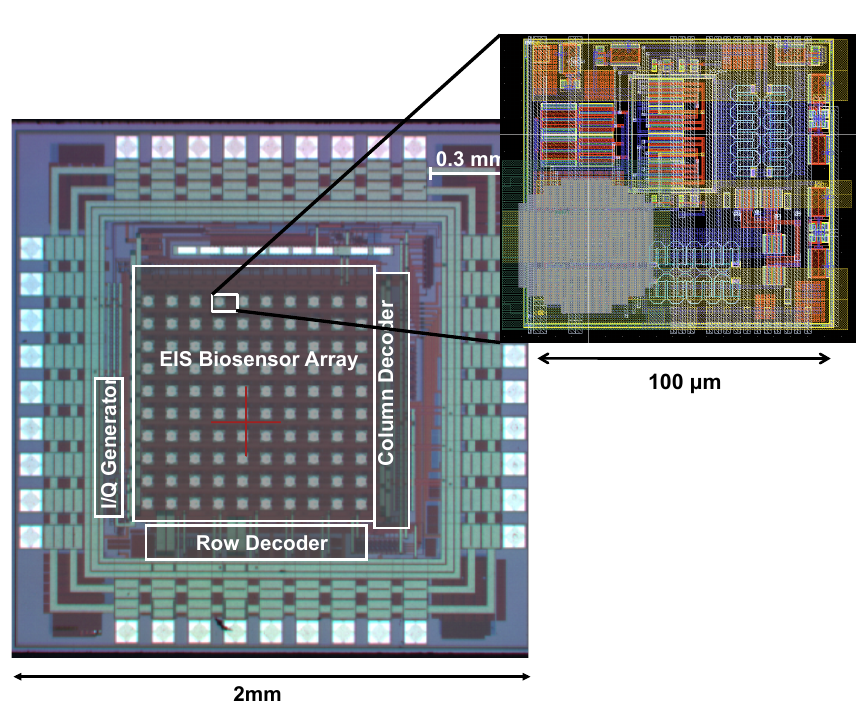
Figure 7. Die photograph.